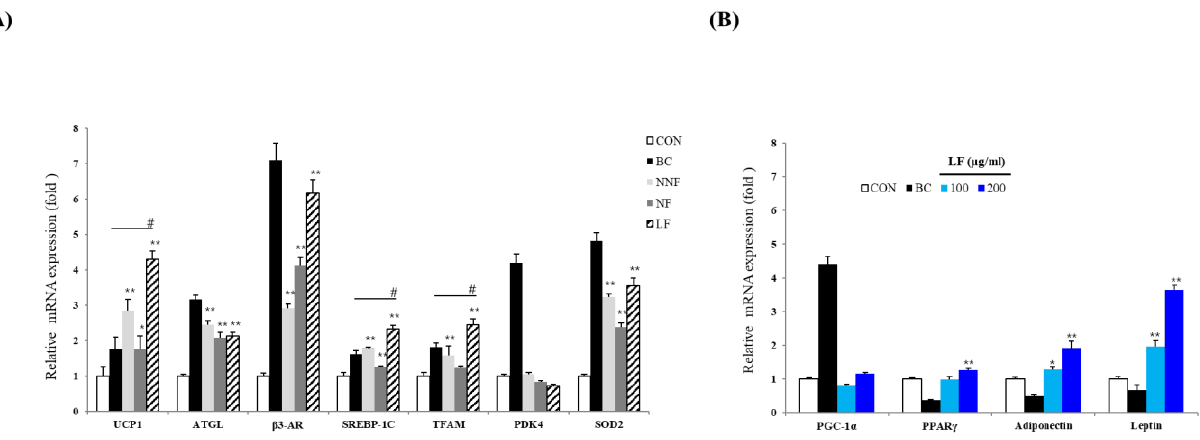
Figure 6. Effects of LF on the expression of adipogenic and thermogenic marker genes: ( A ) The mRNA level of UCP-1, ATGL, β 3-AR, SREBP-1c, TFAM, PDK4, and SOD2 of each indicated group. The expression level of each gene was normalized to that of Actb and was expressed relative to the control. BC, treating the 3T3-L1 adipocytes with a browning cocktail. The bars represent the means ± SD of three independent experiments. * p < 0.05 and ** p < 0.01, comparison to the control. # p < 0.01, comparison to BC. ( B ) The expression of Ppargc1a, Pparg, Adipoq, and Lep. The mRNA level of each gene was normalized to that of Actb and expressed relative to the control. The bars represent the means ± SD of three independent experiments. * p < 0.05 and ** p < 0.01, comparison to the control.